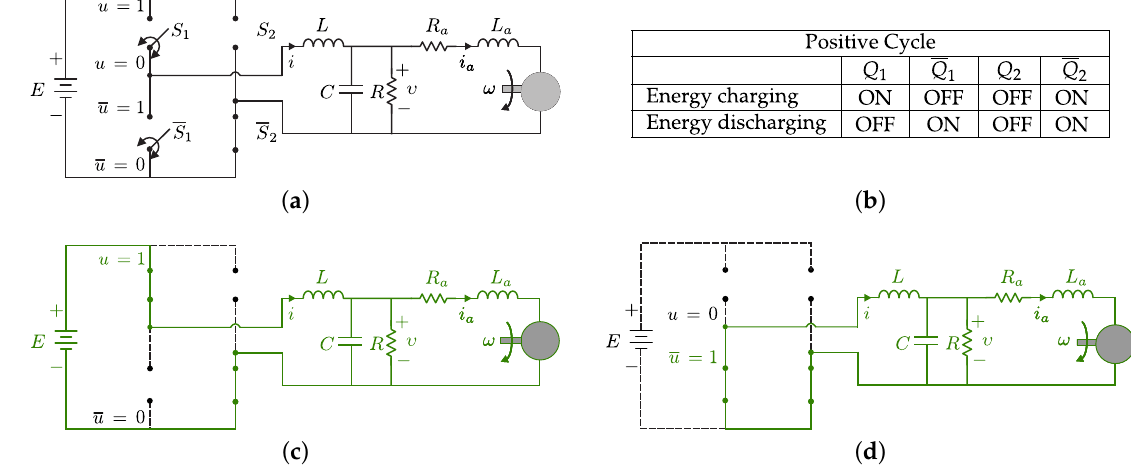
Figure 2. The full-bridge Buck inverter–DC motor system: ( a ) ideal circuit for positive cycle; ( b ) in positive cycle Q 1 and Q 1 of Figure 1 operate as a transistor and as a diode, respectively; ( c ) energy charging mode of operation; and ( d ) energy discharging mode of